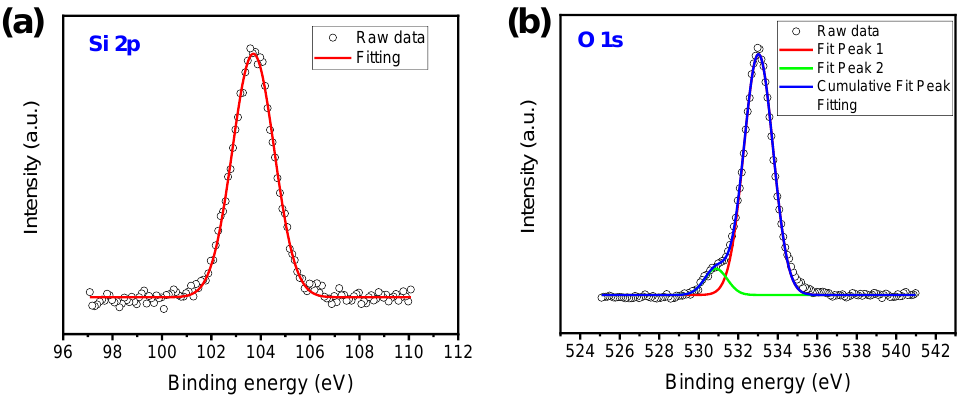
Figure 2. The XPS core level spectra of the ALD deposited SiO X film: ( a ) Si 2p; ( b ) O 1s.